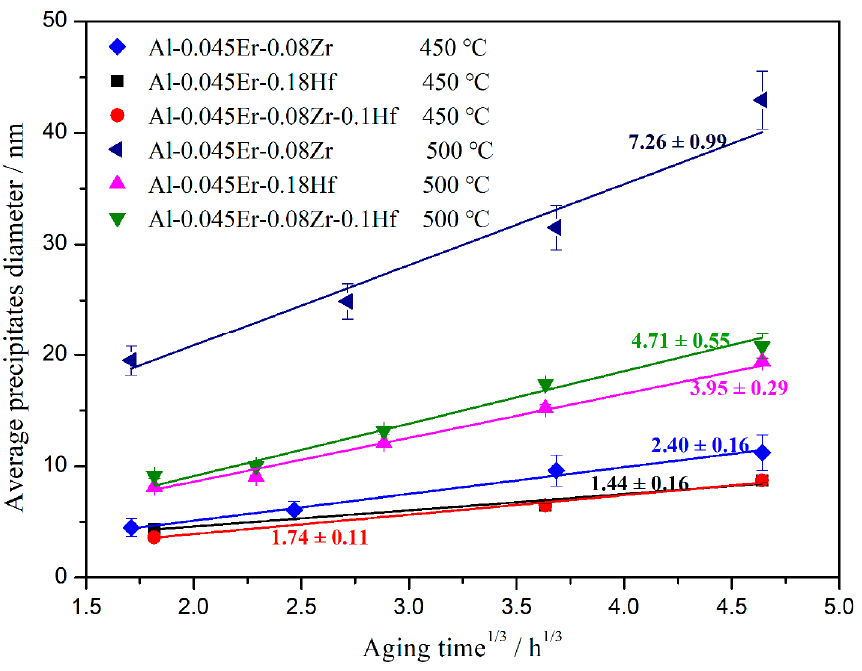
Figure 4. Average diameter of precipitates as a function of the cube root of the annealing time.